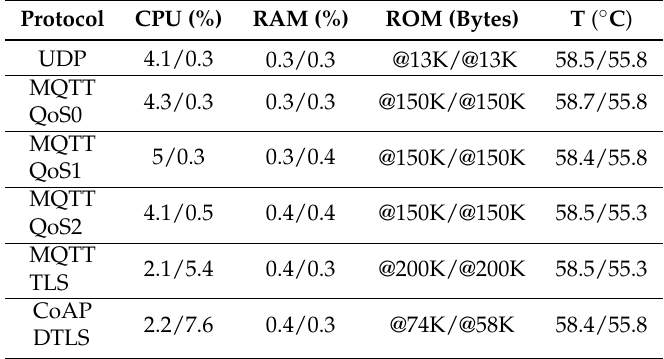
Table 4. Resources needed for networking protocols on the consumer (left) and aggregator